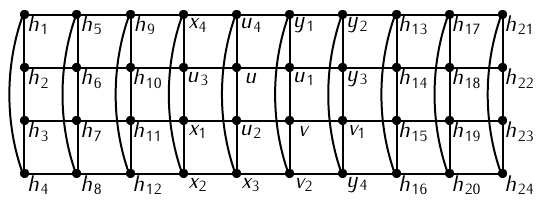
Figure 3. The subgraph H